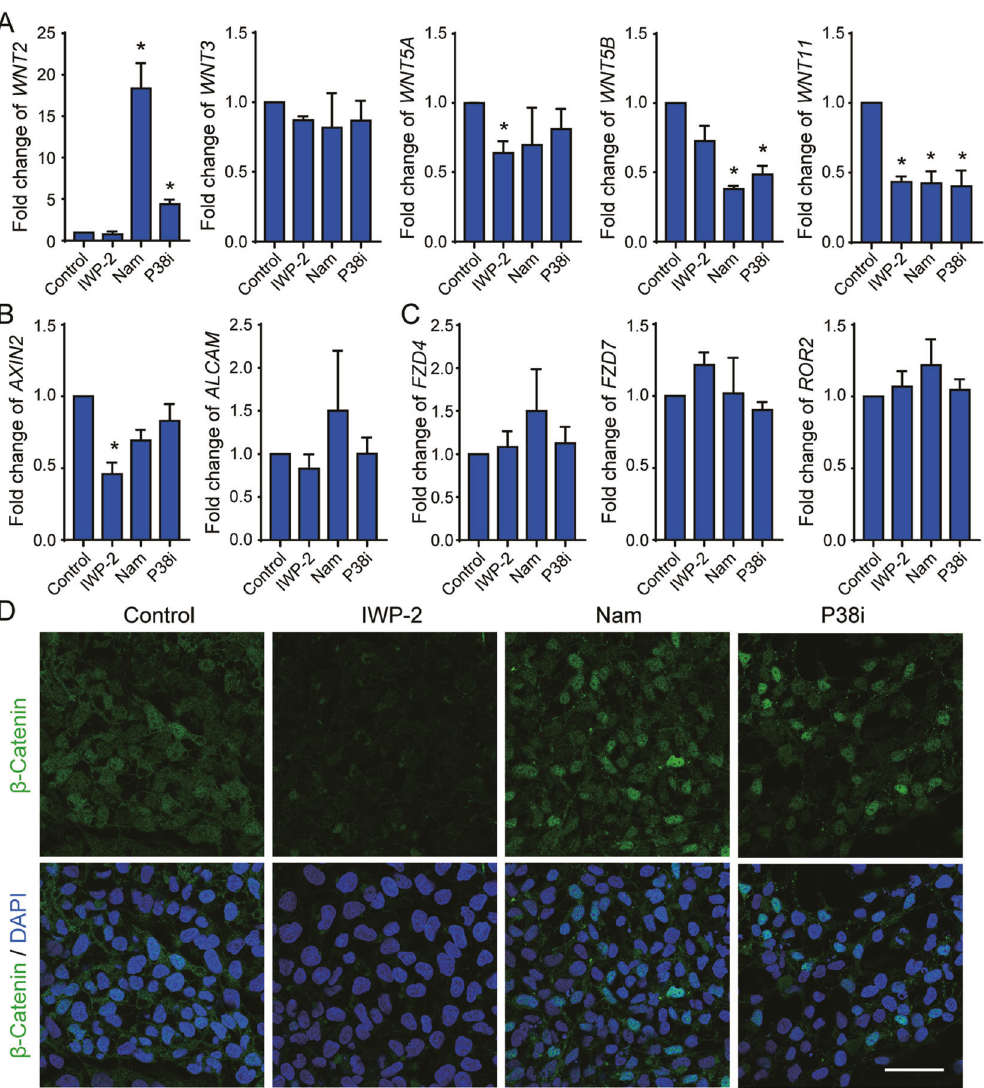
Fig. 4 Nicotinamide-induced cardiac differentiation is independent of canonical WNT inhibition. A Analyses of gene expression of WNTs after 5 days of differentiation by qPCR. B Gene expressions of the downstream targets of canonical WNT ( AXIN2 ) and noncanonical WNT ( ALCAM ) after 5 days of differentiation. C Gene expression of WNT receptors after 5 days of differentiation. D Confocal microscopy images showing the immunostaining images of β -Catenin in differentiated cells treated with IWP-2, nicotinamide (Nam), or P38 inhibitor (P38i). After plating for 2 days, hESCs were treated with CHIR99021 5 μ M for 1 day, and then IWP-2 (3 μ M), nicotinamide (20 mM) or P38 inhibitor SB202190 (10 μ M) for 1 day to examine their impact on β -Catenin expression. Scale bar, 50 μ m. Data shown are normalized to control, and represent mean ± SD of three independent experiments (* p < 0.05 compared with